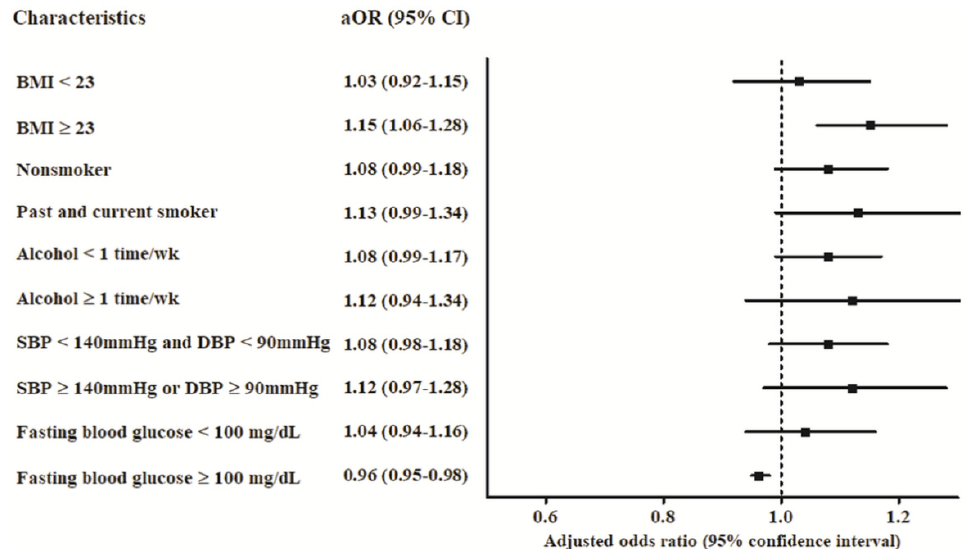
Figure 2. Adjusted odds ratios and 95% confidence intervals were calculated for the risk of PD associated with anemia stratified by comorbidities. aOR–Adjusted odds ratio; BMI–Body mass index; CI–Confidence interval; DBP–Diastolic blood pressure; SBP–Systolic blood